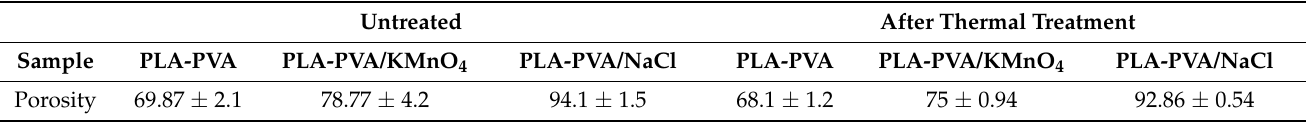
Table 2. Porosity measurements of porous bioscaffolds after 24 h of immersion in ethanol at room temperature. Untreated After Thermal